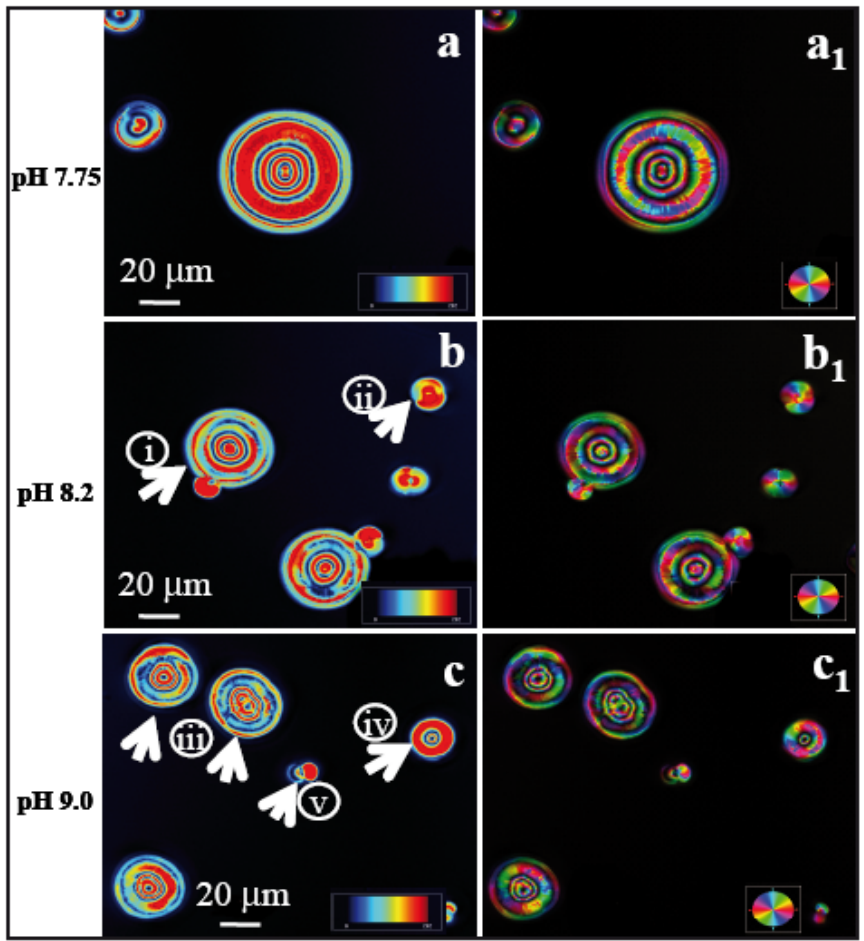
crystals grown in presence of peptide ES9 Figure 4. LC-PolScope images of CaCO 3 (pI 9.41) at pH 7.75, pH 8.2, and pH 9.0. Birefringence data show the retardance and orientation images left and right, respectively. Scale bar: 20 µm. ( a , a ) Peptide ES9 at 1 ) Peptide ES9 at pH 8.2, c = 10 mM; ( c , c ) Peptide ES9 at pH 7.75, c = 10 mM; ( b , b 1 1 pH 9.0, c = 10 mM. The numbers in figures ( b ) (i, ii) and ( c ) (iii–v) indicate the different morphologies of CaCO crystals. Note that the outer ring of polycrystals shows retardance 3 values in the blue range